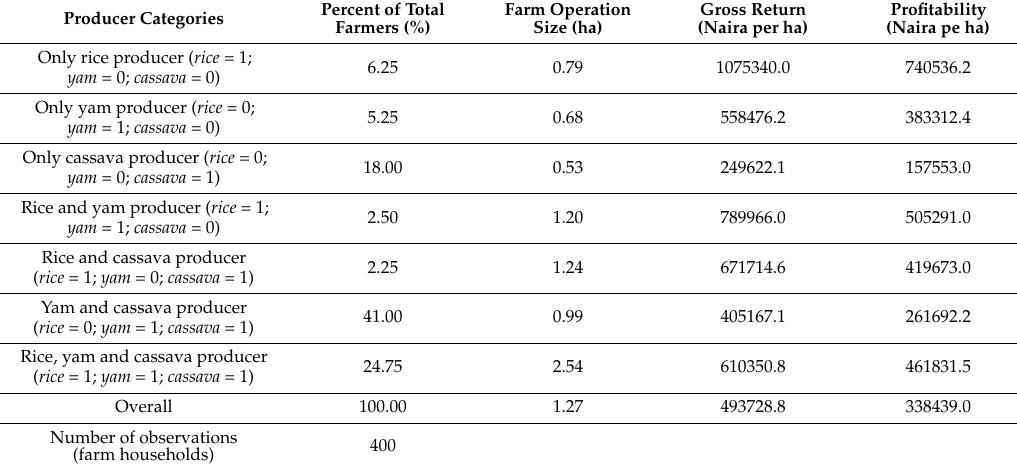
Table 1. Extent of food crop diversity and profitability amongst the sampled